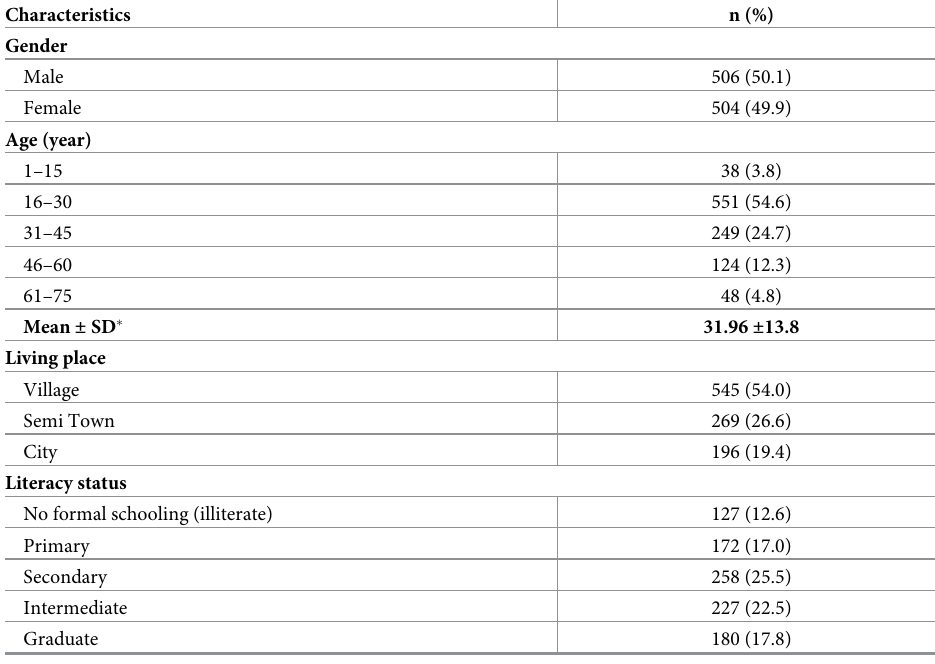
Table 1. Socio-demographic characteristics of the respondents in Bangladesh.